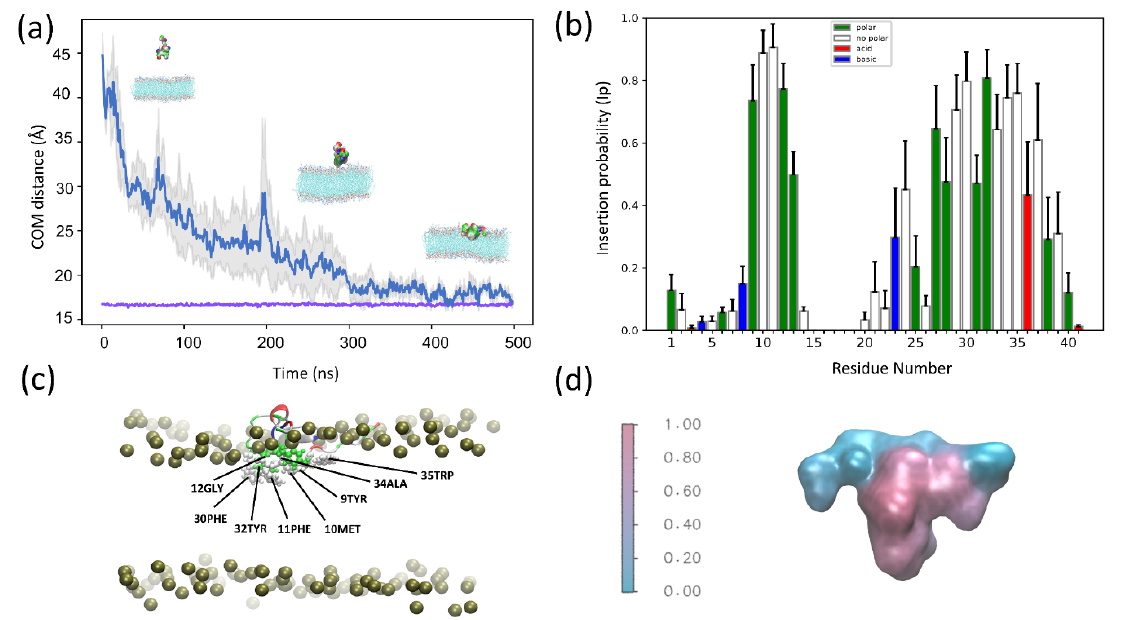
Figure 4. All-atom MD simulations of SNX-482 and POPC: POPG (3:1) ( a ) Average distance as a function of time between the center of mass (COM) of SNX-482 and the (COM) of the membrane bilayer for four independent simulations. The gray colored region corresponds to the mean error of the distances The purple line represents the position of the membrane outer leaflet. ( b ) Average insertion probabilities (Ip) for each residue. ( c ) Snapshot showing SNX-492 residues embedded in the membrane. ( d ) Surface representation of SNX-482 colored by Ip.